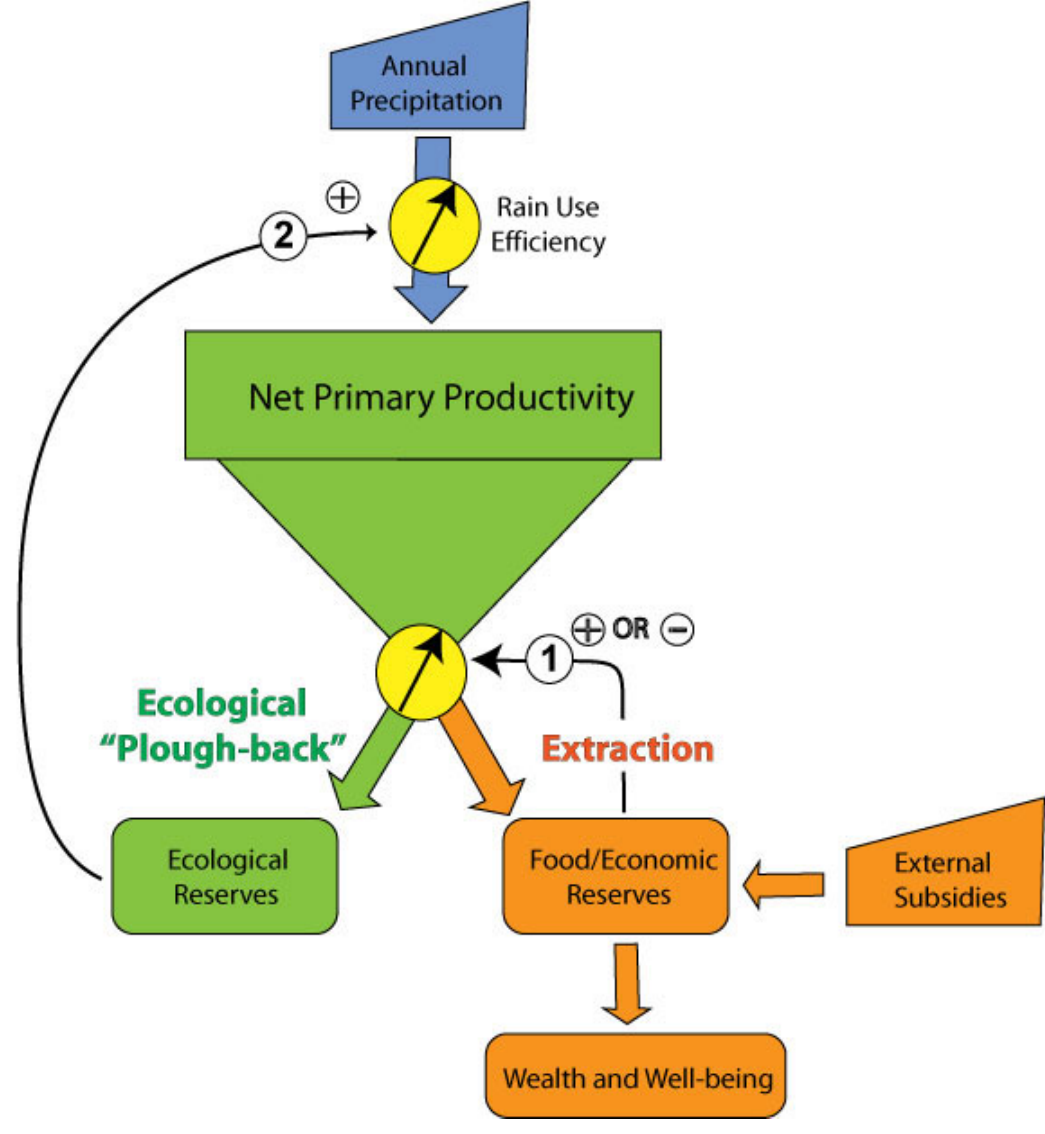
Fig. 5. Ecologic and economic reserves compete for net primary productivity. The division of net primary productivity is regulated by the extraction effort (“control loop” 1). Increasing extractive effort will reduce ecological “plough-back” and diminish ecological reserves. Reduced ecological reserves will reduce rain-use efficiency (“control loop” 2) and future primary productivity. Economic reserves are bolstered by external subsidies, e.g., government payments. Critical to sustainable management is the nature of the feedback of economic reserves on extractive effort. A positive feedback will lead to overexploitation, a negative feedback may promote system resilience (see text for